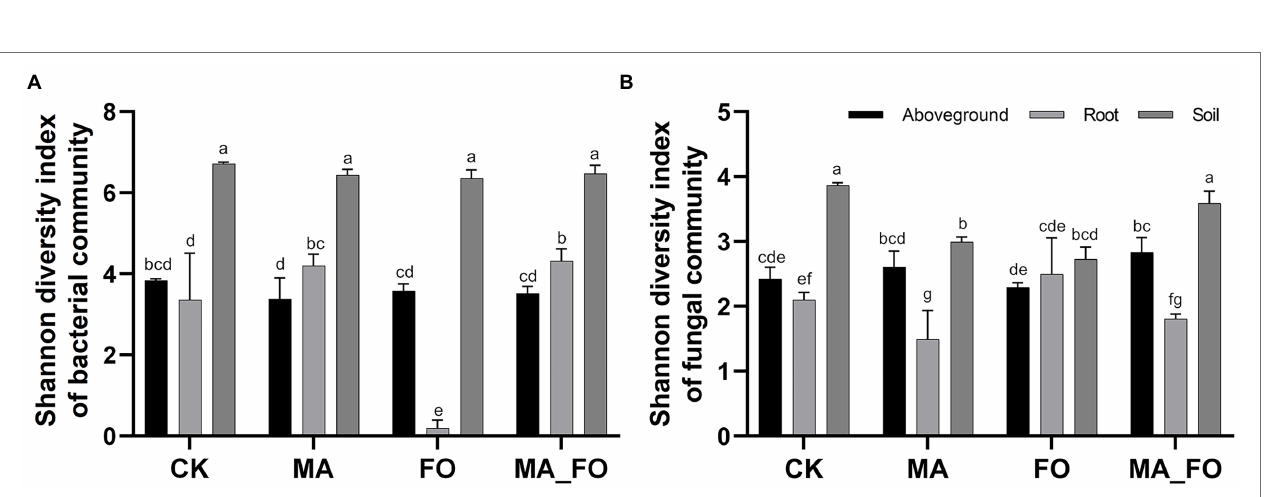
FIGURE 4 | Shannon diversity index of bacterial (A) and fungi (B) community structure at different ecological niches (Aboveground: aboveground of ginseng; Root: root of ginseng; Soil: rhizosphere soil). Different lowercase letters indicate significant difference ( p <